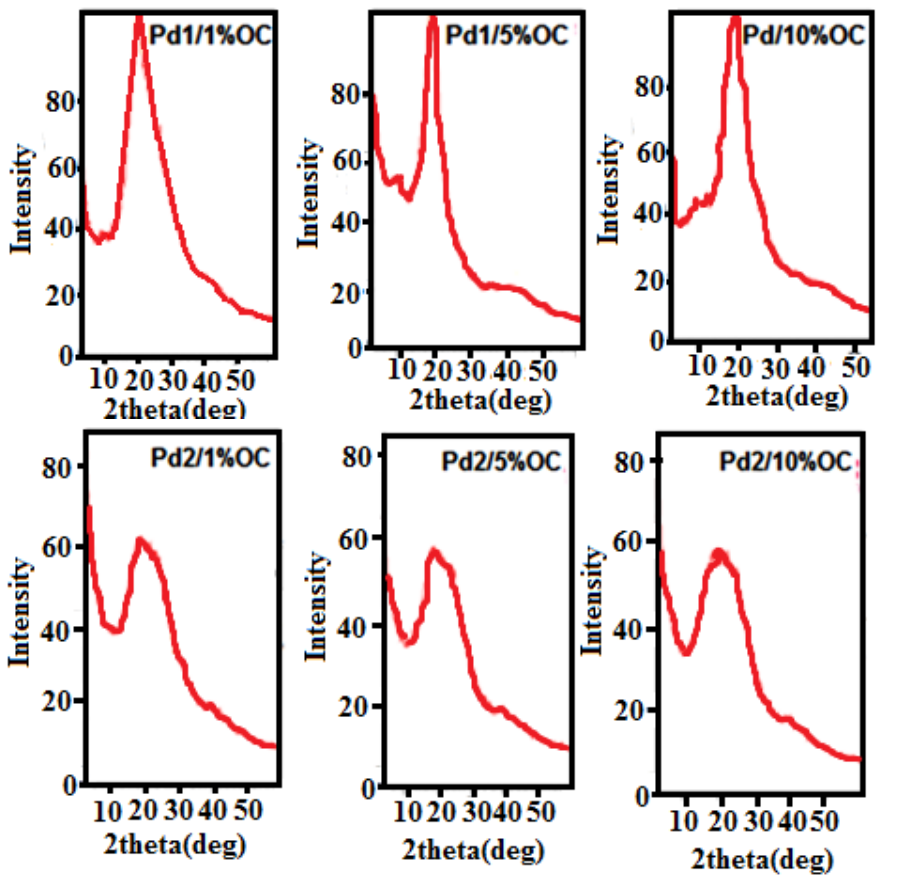
Figure 4: X ray diffraction (XRD) pattern of Pd1(PS/PVA:10/90),Pd1/1%OC, Pd1/5%OC, Pd1/10%OC, Pd2(PS/PVA:90/10),Pd2/1%OC, Pd2/5%OC,